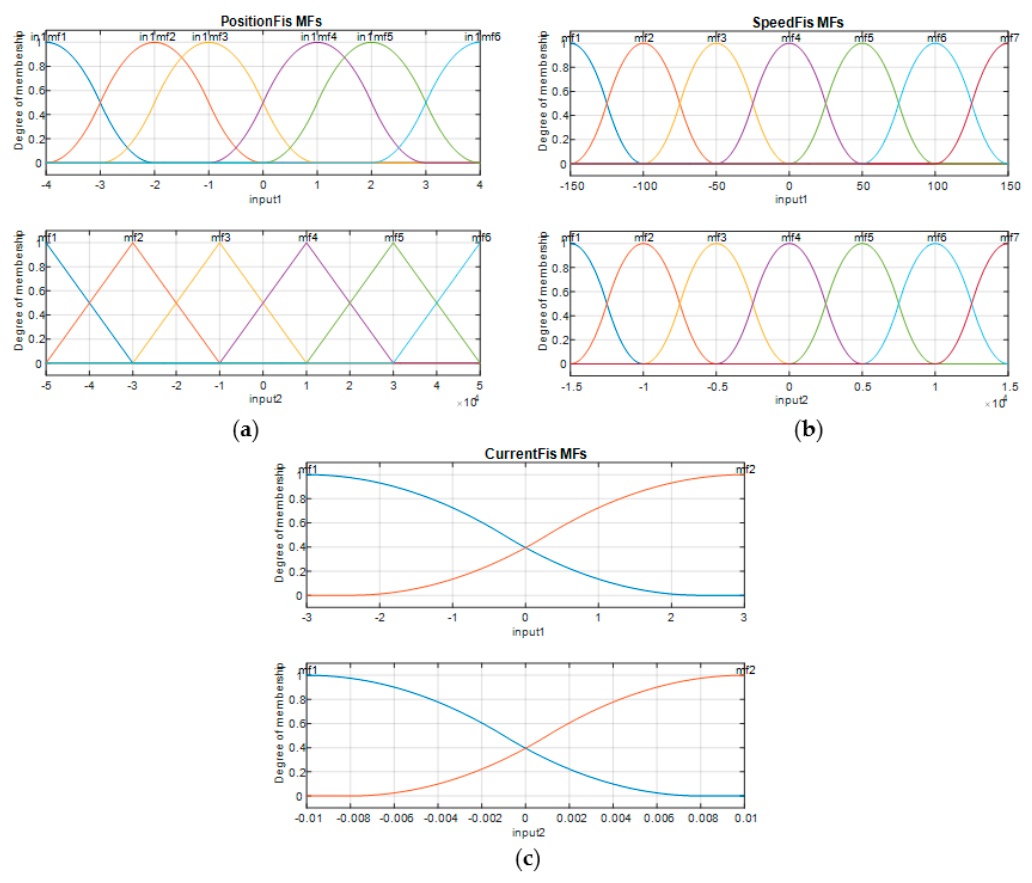
Figure 10. Membership functions for the FISs inputs: ( a ) PositionFIS, ( b ) SpeedFIS, and ( c )